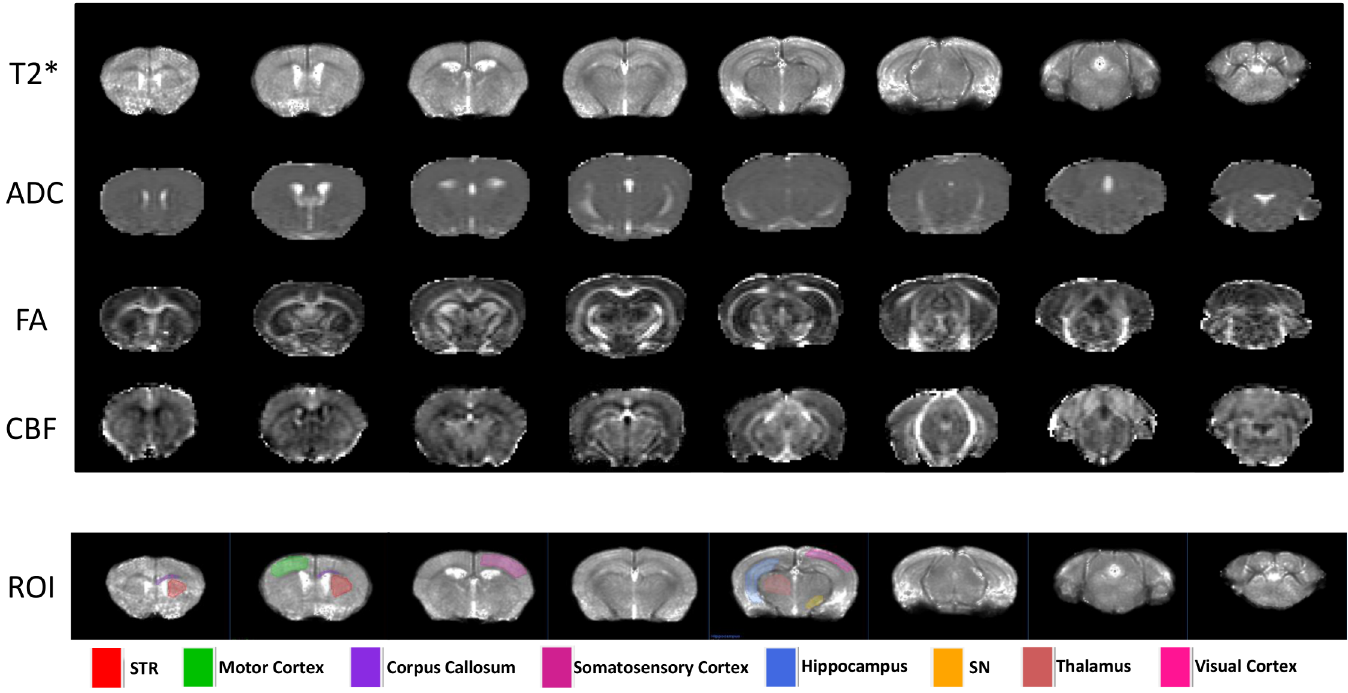
Fig 2. T2 * maps, apparent diffusion coefficient (ADC), fractional anisotropy (FA) and cerebral blood flow (CBF) from one wild-type mouse, and ROIs of various brain regions used for quantitative analysis. Only unilateral ROIs are shown here, but bilateral ROIs were used for analysis. STR: striatum; SN: substantia nigra.